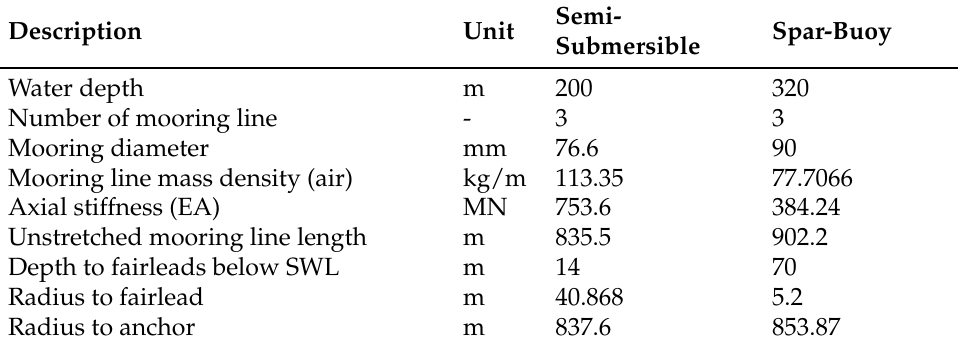
Table 2. Specification of mooring systems